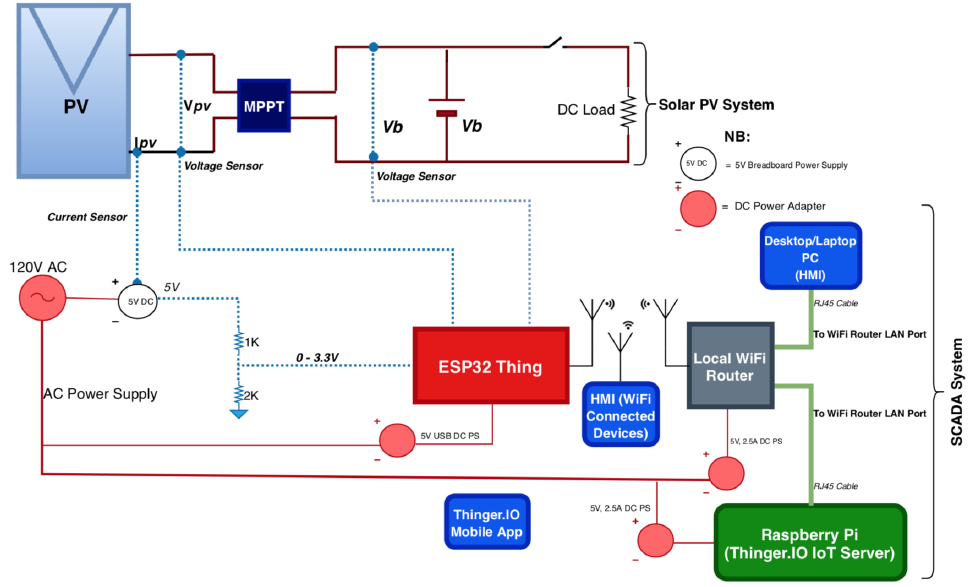
Figure 2. The second configuration (B) of the proposed SCADA